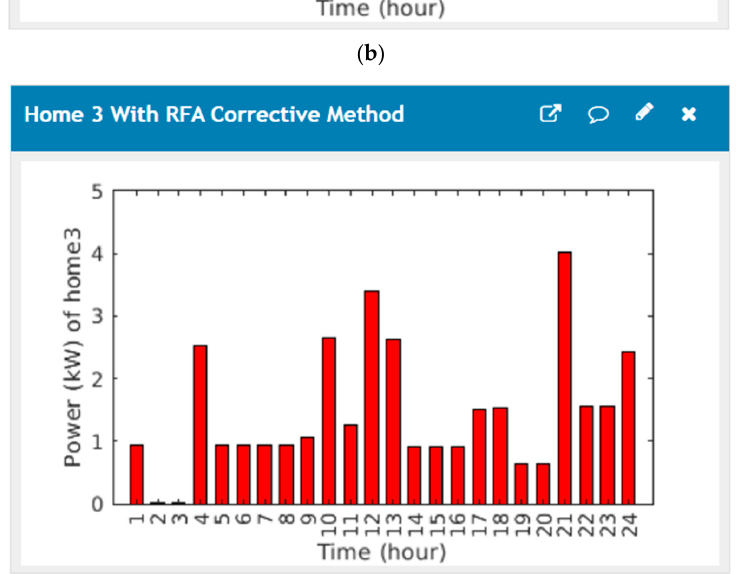
Figure 11. Power GUI of the suggested home structure after implementing the RFA algorithm: ( a )